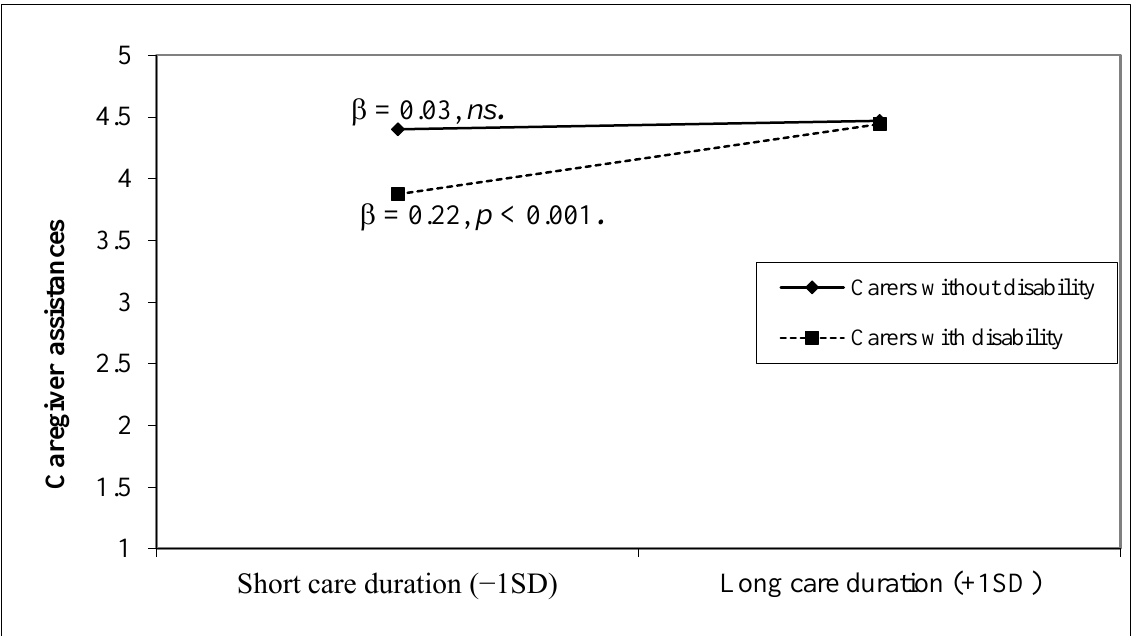
Figure 2. Relationships between care duration and perception of the importance of service improve- ment among carers on caregiver assistances.